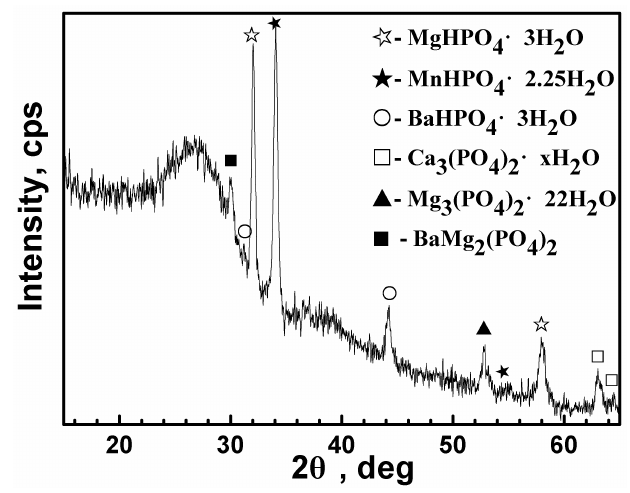
Figure 4. XRD spectrum of the film.